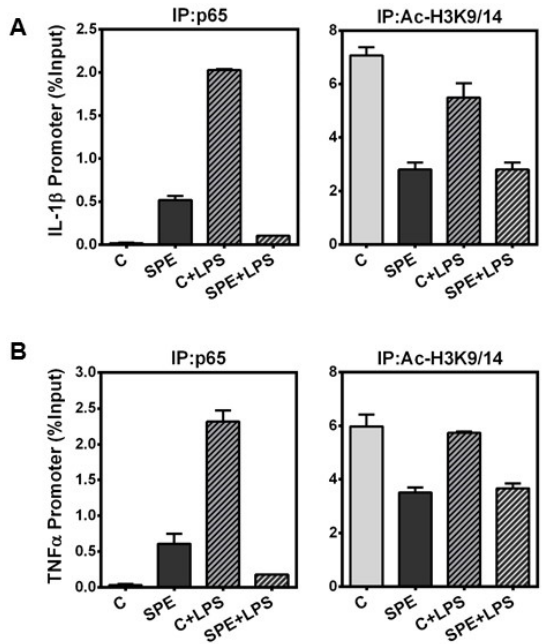
Figure 6. Chromatin Immunoprecipitation of p65 and H3K9/K14 at the promoter of inflammatory genes. ChIP of RAW 264.7 macrophages pretreated with 100 µ g/mL of SPE for 12 h and then stimulated with 100 ng/mL of LPS for an additional 18 h in the presence of SPE. ChIP DNA was obtained by immunoprecipitation of p65 (left) and histone H3K9 (right) and quantified by qPCR with primers at the ( A ) IL-1 β promoter and ( B ) TNF α promoter.